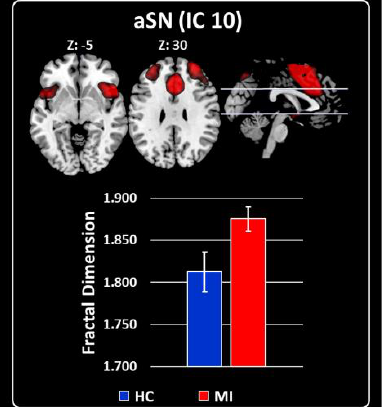
Figure 3. Grand average and standard error for the FD values are shown for both groups HC (blue) and MI (red). Upper panel shows the results obtained for aSN (IC 10). All were co-registered into the Montreal Neurological Institute (MNI) space.